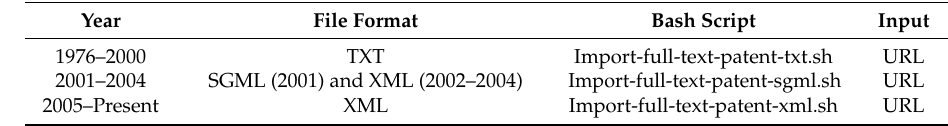
Table 1. The full text patent file formats and bash